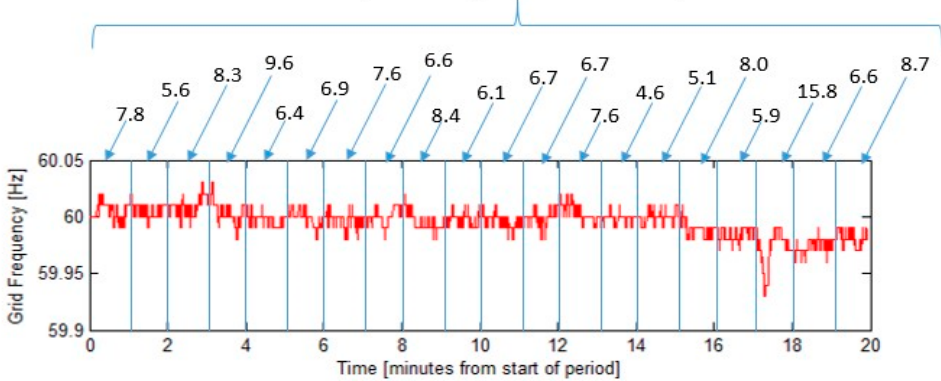
Figure 8. A frequency time-series is divided into several smaller segments, in this case 60-seconds in length. The standard deviation of each smaller time series is shown as just above the plot. The mean of those values is taken to be the “frequency variability” of the 20-min period on a 60-seconds